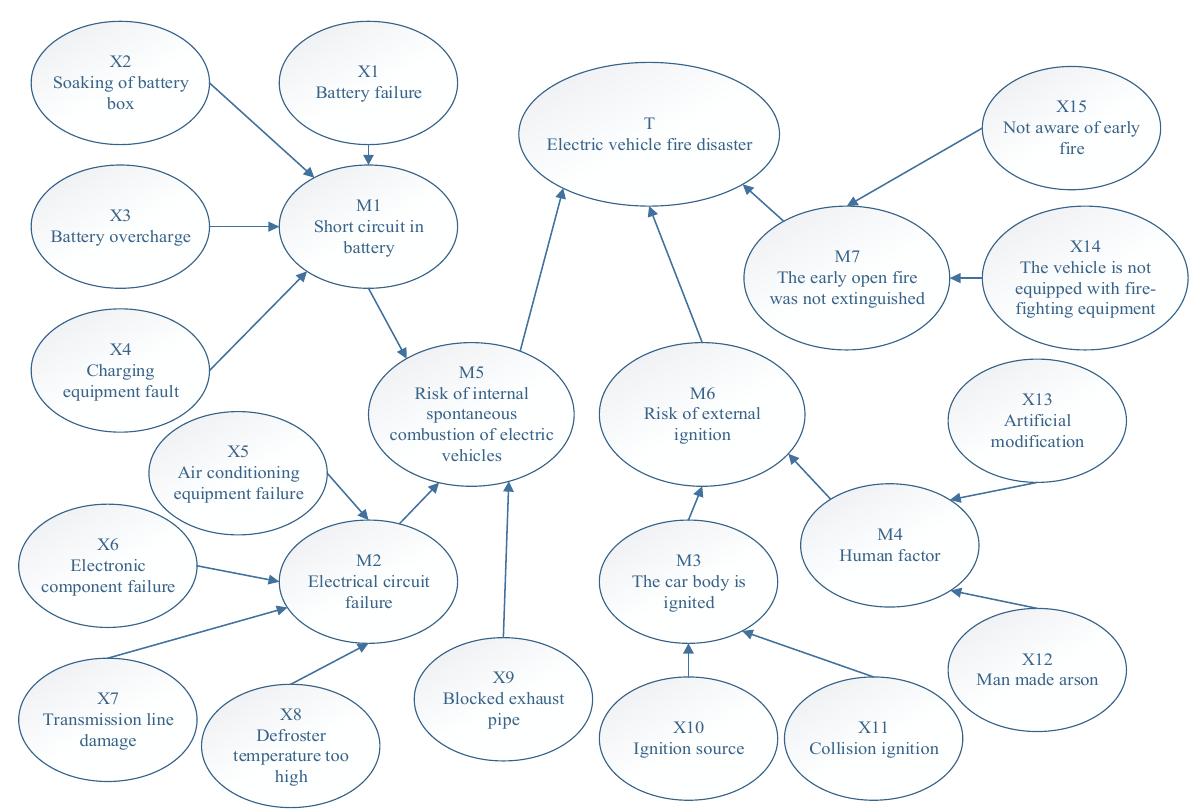
Figure 9. BN structure diagram of electric vehicle fire.